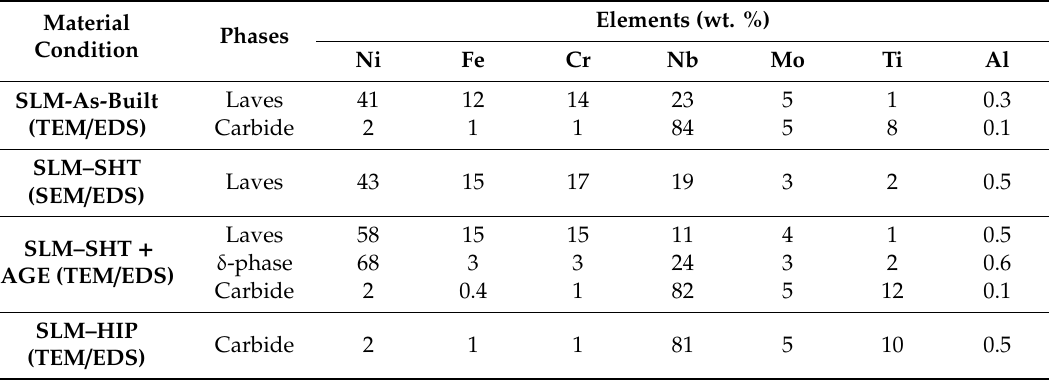
Figure 6. Microstructure of wrought Alloy 718 showing equiaxed grain structure and NbC carbides marked with arrows (electrolytically etched with oxalic acid). Table 3. Chemical composition of the phases, detected in all selective laser melting (SLM) conditions, determined by the Transmission electron microscopy (TEM / EDS) and Scanning electron microscope (SEM / EDS)